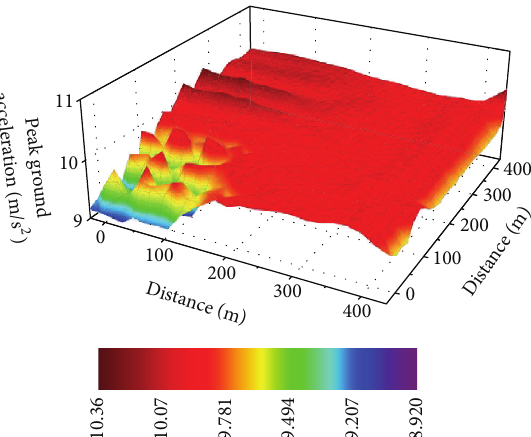
Figure 32: Peak ground acceleration distribution of URBAN6-6 (1/4 FE model, 𝐷 = 0.5 , V 𝑠 = 2 V 𝑠 , El Centro, 𝑆𝑋 ).